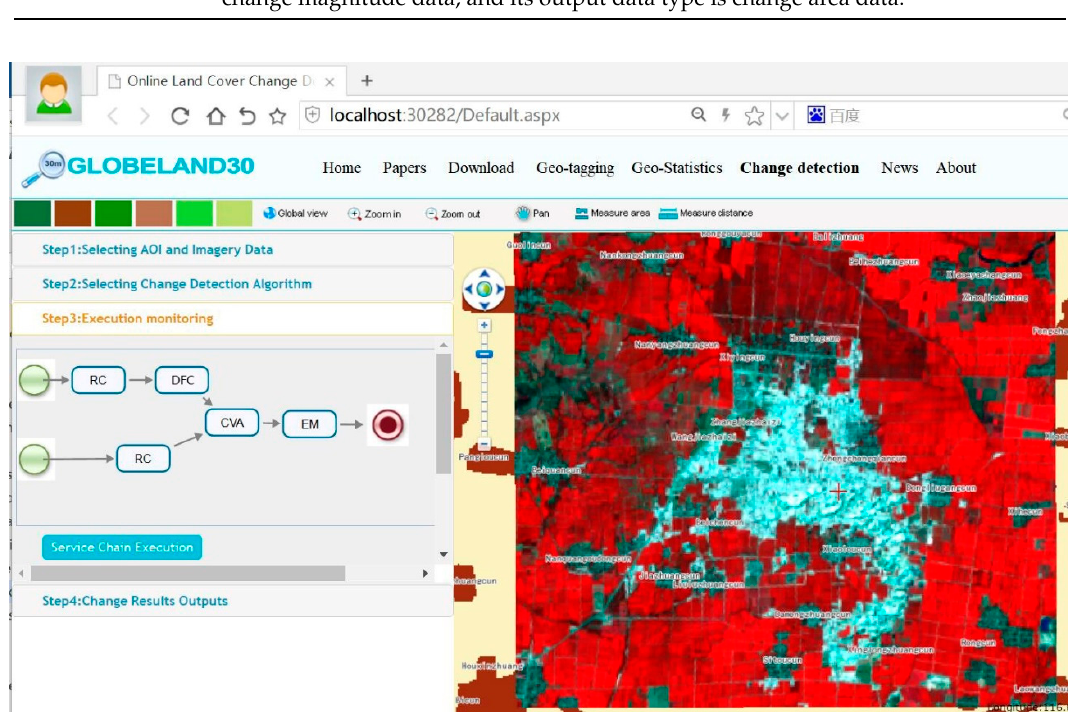
Figure 8. Service chain generation for change detection.